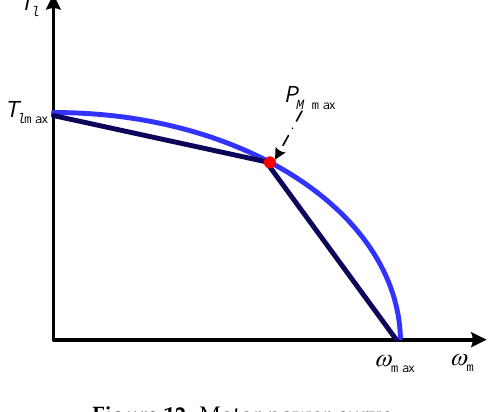
Figure 12. Motor power curve.